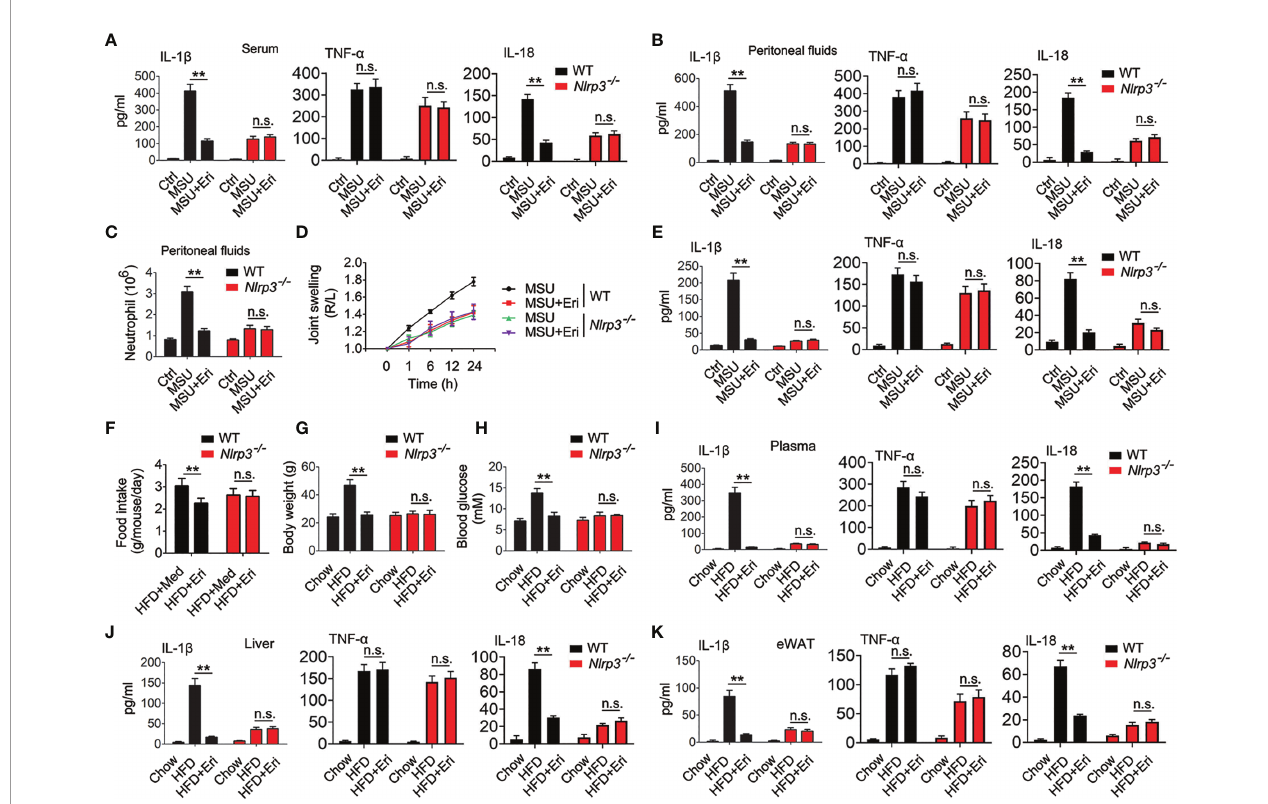
FIGURE 6 | Eri inhibits peritonitis, gouty arthritis and metabolic disorders via NLRP3. (A, B) WT or Nlrp3 -/- mice were intraperitoneally injected with Eri (5 mg/kg) for 12 h. Then, mice were intraperitoneally injected with MSU (1 mg/mouse) for 6 h. IL-1 b , IL-18 and TNF- a protein levels in serum (A) or peritoneal fl uids (B) were determined by ELISA. (C) Experiments were performed as described in (B) , except neutrophil numbers in the peritoneal cavity were analyzed using FACS. (D) WT or Nlrp3 -/- mice were intraarticularly injected with Eri (0.5 mg/kg) for 1 h. Then, mice were intraperitoneally injected with MSU (0.5 mg/mouse). Joint swelling was measured at the indicated times. (E) WT or Nlrp3 -/- mice were intraarticularly injected with Eri (0.5 mg/kg) for 1 h. Then, mice were intraperitoneally injected with MSU (0.5 mg/mouse) for 24 h IL-1 b , IL-18 and TNF- a protein levels in joint culture were determined by ELISA. (F – H) WT or Nlrp3 -/- mice were fed with HFD for 12 weeks. Then, the mice were treated with the indicated concentrations of Eri every other day for 4 weeks. Food intake (F) and body weights (G) were recorded, and blood glucose levels (H) were measured. (I) Experiments were performed as described in (F) , except IL-1 b , IL-18 and TNF- a protein levels in plasma were determined by ELISA. (J, K) WT or Nlrp3 -/- mice were fed with HFD for 12 weeks. Then, the mice were treated with the indicated concentrations of Eri every other day for 4 weeks. Liver (J) and white adipose tissue (WAT) (K) were isolated and cultured for 24 h. IL-1 b , IL-18 and TNF- a protein levels in supernatants were determined by ELISA. Bar graphs present means ± SEM, n = 5 for each group (**P < 0.01). n.s., not signi fi